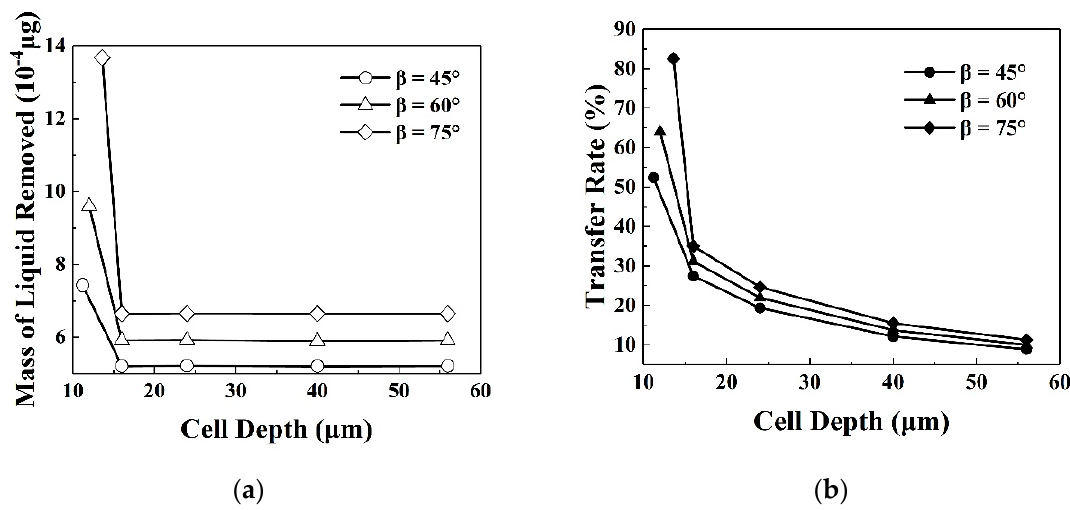
Figure 10. The change trend of ( a ) the mass of liquid removed and ( b ) the transfer rate with cell depth ( α = 30°).